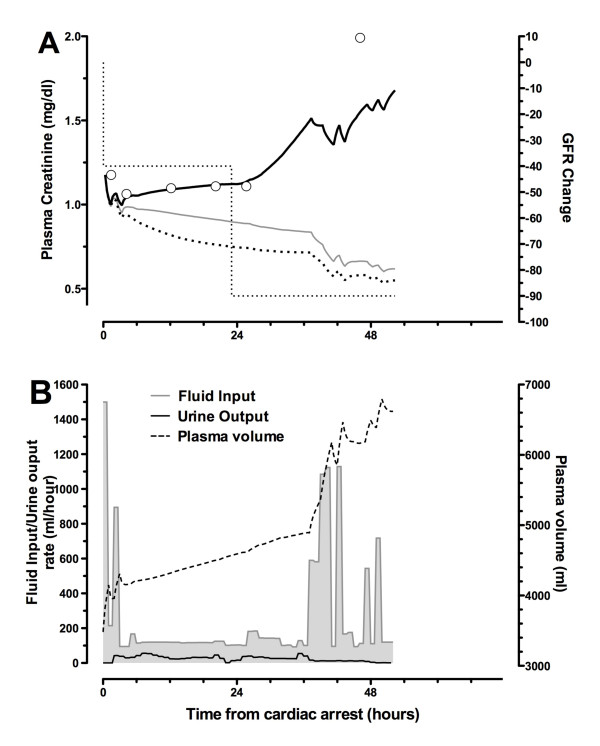
Case B: Crunchanged. Plasma creatinine changes (a) and fluid input/urine output and plasma volume (b) are shown. Fluids alone (no change in glomerular filtration rate (GFR) and no reduction in creatinine production) suggest that a decrease in plasma creatinine should have been observed (grey line). If there had been a reduction in creatinine production (Figure 4), the decrease would have been greater (dotted line). A model including a reduction in creatinine, fluids in and out, and a reduction of 40% in GFR increasing to 90% at about 24 hours best fits the measured creatinine. The patient became anuric despite multiple boluses and died at 53 hours. Crunchanged, group of patients in whom plasma creatinine increased no more than 20% or decreased no more than 10% at 24 hours after cardiac arrest.